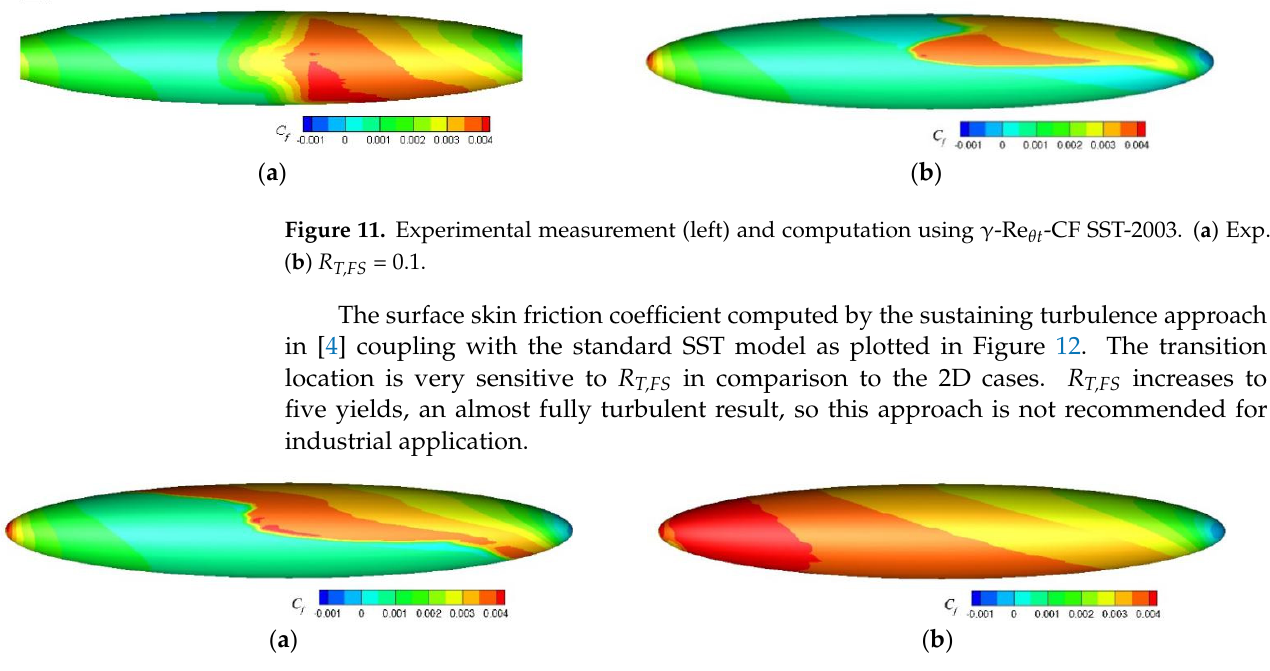
Figure 12. γ -Re θ t -CF SST transition model with sustaining turbulence term in [4]. ( a ) R T,FS =1.0. ( b ) R T,FS =5.0.